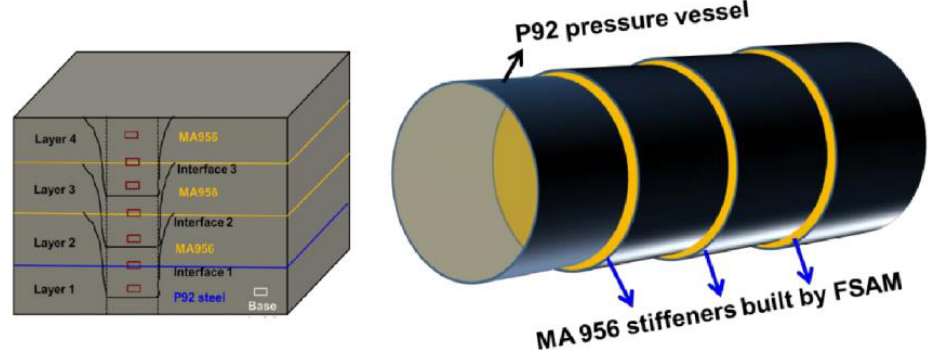
26 of 35 Figure 21. Experimental setup and complex part produced through FSAM by Edison Welding Institute (EWI) (© EWI. reprinted from [125,126] with permission from EWI). 6.2. Potential Practical Application of FSAM The aerospace industry requires lightweight, high-efficiency structural components. The nut-bolt assembly increases overall weight, and another significant issue is the weld- ability of aerospace aluminum alloy using conventional welding techniques. At the mo- ment, the parts are made using a subtractive manufacturing process. This entails begin- ning with plate metal with a thickness equal to the overall part thickness. The material is then machined away in order to create the desired shape or ribbed surface. Ninety percent of the starting martial could be machined away using the process to create the final part. This results in high machining costs and a large amount of material waste. So, FSAM opens avenue for production of such parts, which are discussed blow. Potential application I: This technique can be extended to design and manufacture stiffer assemblies such as ribs, fuselage stringers, I beams, and longerons skin panels in the aerospace sectors, as shown in Figure 22 [48]. Figure 22. Stiffener/stringer assembly fabrication through FSAM: ( a ) I-beam; ( b ) Fuselage; ( c ) Air foil cross-section. Potential application II: In nuclear and fossil sectors, creep resistant structure can be obtained through this technique. The partial and full stiffener rings, which could be